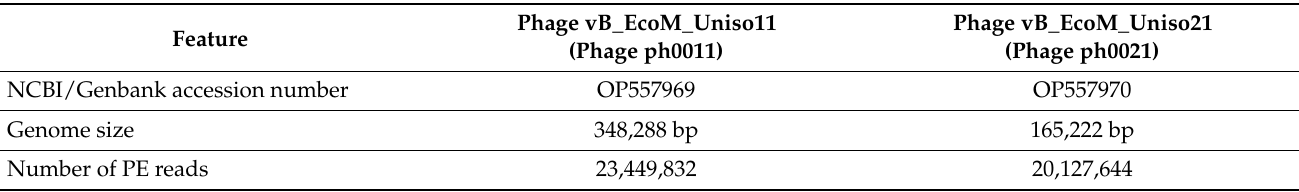
Table 5. Genomic features of phages ph0011 and ph0021